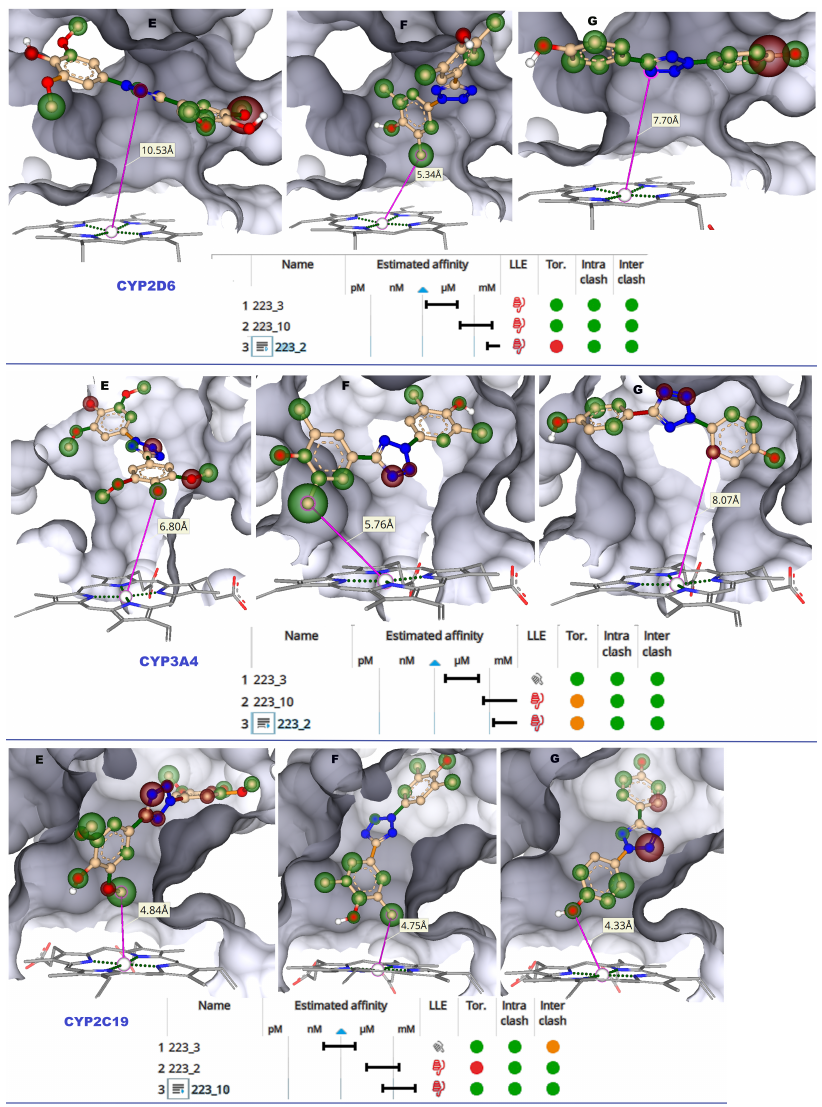
Figure 4. Images of CYP2D6, CYP3A4, and CYP2C19 LBP docked with TbB ligands visualized with HYDE atomized coloring. White corona = neutrality, a green-colored corona = the ability of this atom to favorably contribute to BA, and a red-colored corona = the ability of this atom to non-favorably contribute to BA. (E) TbB ligand 223-2 atoms in LBP. (F) TbB ligand 223-3 atoms in LBP. (G) TbB ligand 223-10 atoms in LBP. The size of the corona sphere visually indicates the extent of favourable or non-favourable contribution to the BA. Larger spheres indicate more contribution, and smaller spheres indicate less contribution to the BA. HYDE binding affinity (Ki) estimation of molecular docked poses of 223-2, 223-3, and 223-10 ligands in the active site of CYPs is represented as the range from mM < µ M < nM < pM. Green circle = favourable to BA. Red circle = non-favourable to BA. BA = binding